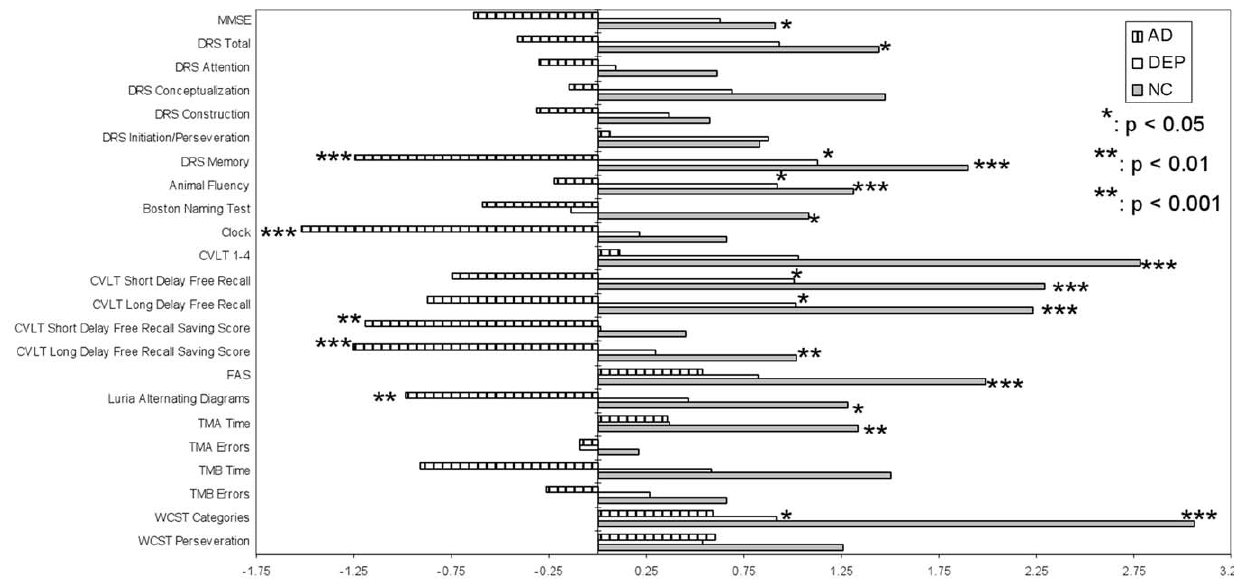
Figure 1. Comparison of Cognitive Performances of Patients with Alzheimer’s Disease, Depressive Disorder, or Normal Cognition to those with Late-Life Schizophrenia. Cohen’s effect sizes have been calculated and plotted for the different cognitive tests comparing performances of patients with AD, DEP, or NC to those with LLS (who constitute the reference group). Positive effect sizes indicate that patients with AD, DEP, or NC perform numerically better than patients with LLS. Negative effect sizes indicate that the opposite. * indicates that the difference is statistically significant (p , 0.05) after correcting for multiple comparisons. ** indicates that the difference is statistically significant (p , 0.01) after correcting for multiple comparisons. *** indicates that the difference is statistically significant (p , 0.001) after correcting for multiple comparisons. AD: Alzheimer’s disease; Clock: Clock drawing test – Freedman scale; CVLT: California Verbal Learning Test II- Short Form; DEP: depressive disorder; DRS: Dementia Rating Scale-2; FAS: FAS Letter Fluency; MMSE: LLS: late-life schizophrenia; Mini-Mental Status Examination; NC: normal cognition; TMA and TMB: Trail Making Test A and B, respectively; WCST: Wisconsin Card Sorting Test – 64.